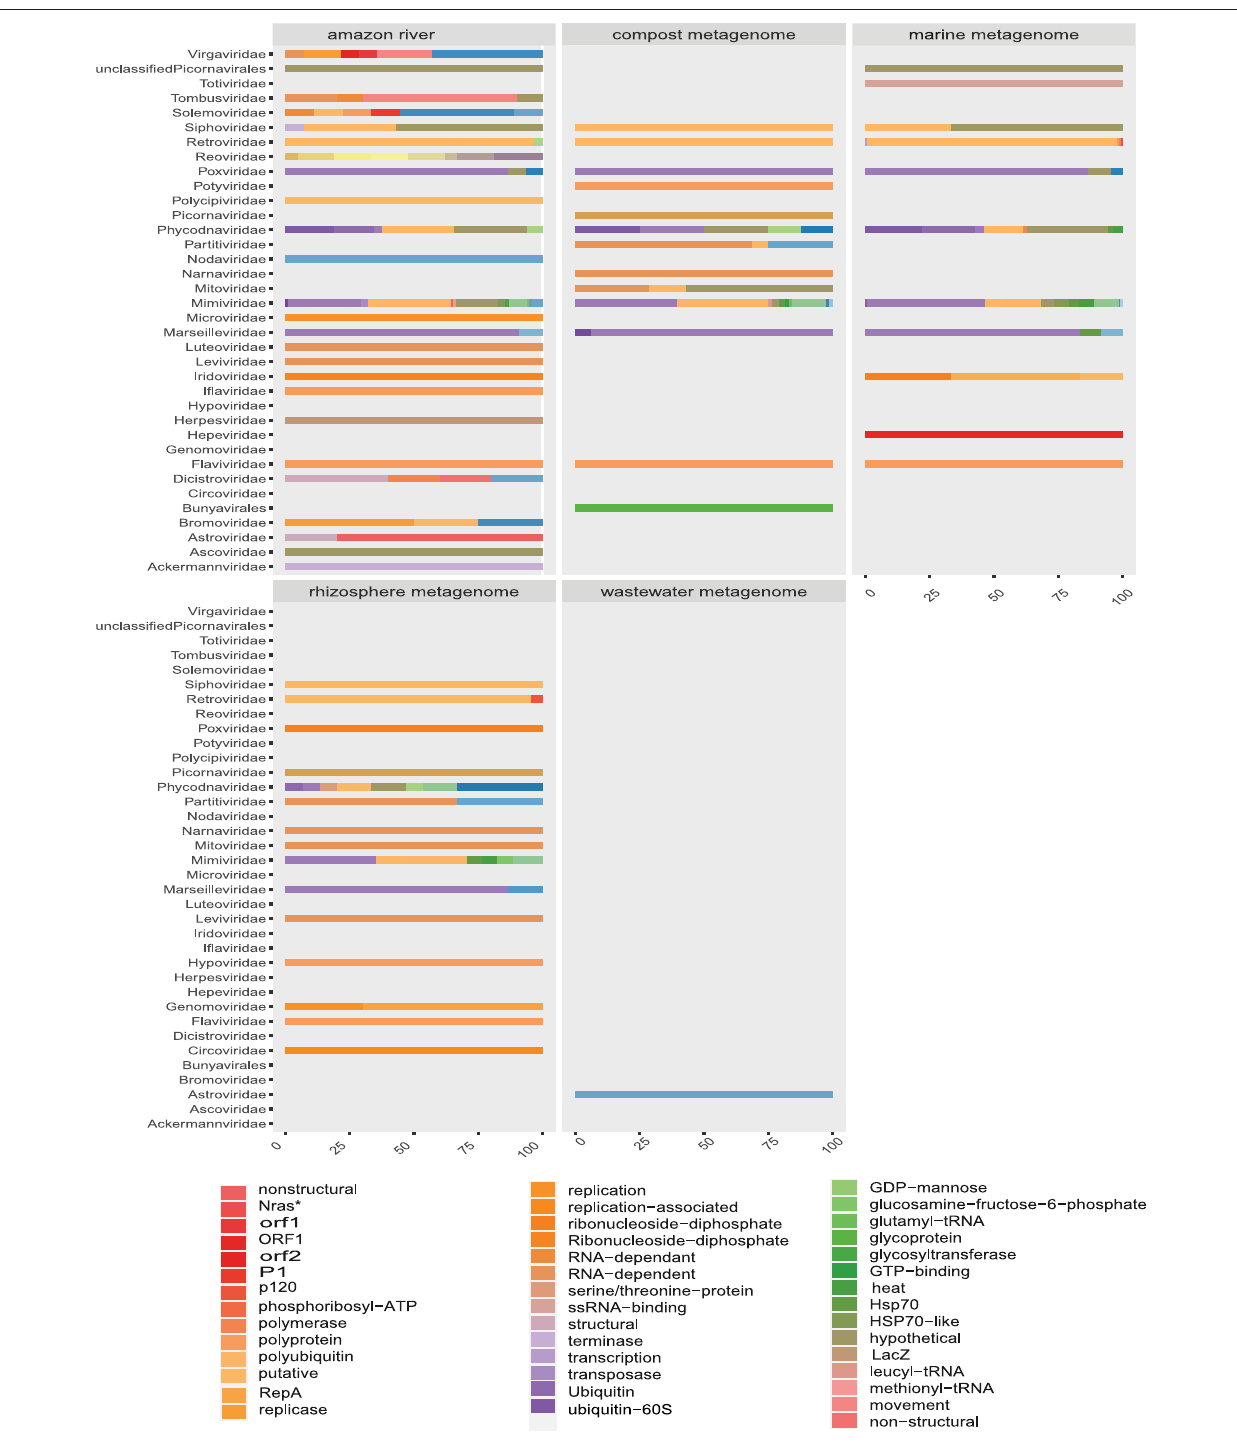
Frontiers in Genetics |